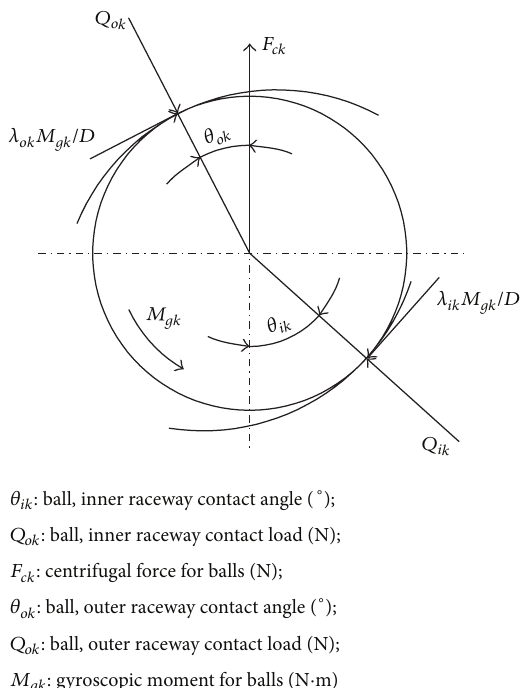
Figure 3: Force analysis of rolling balls.